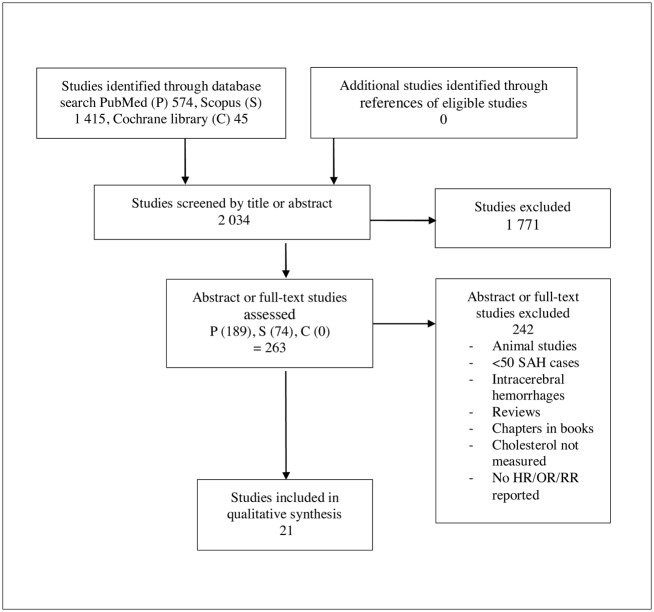
PRISMA Flow diagram.Study selection protocol.